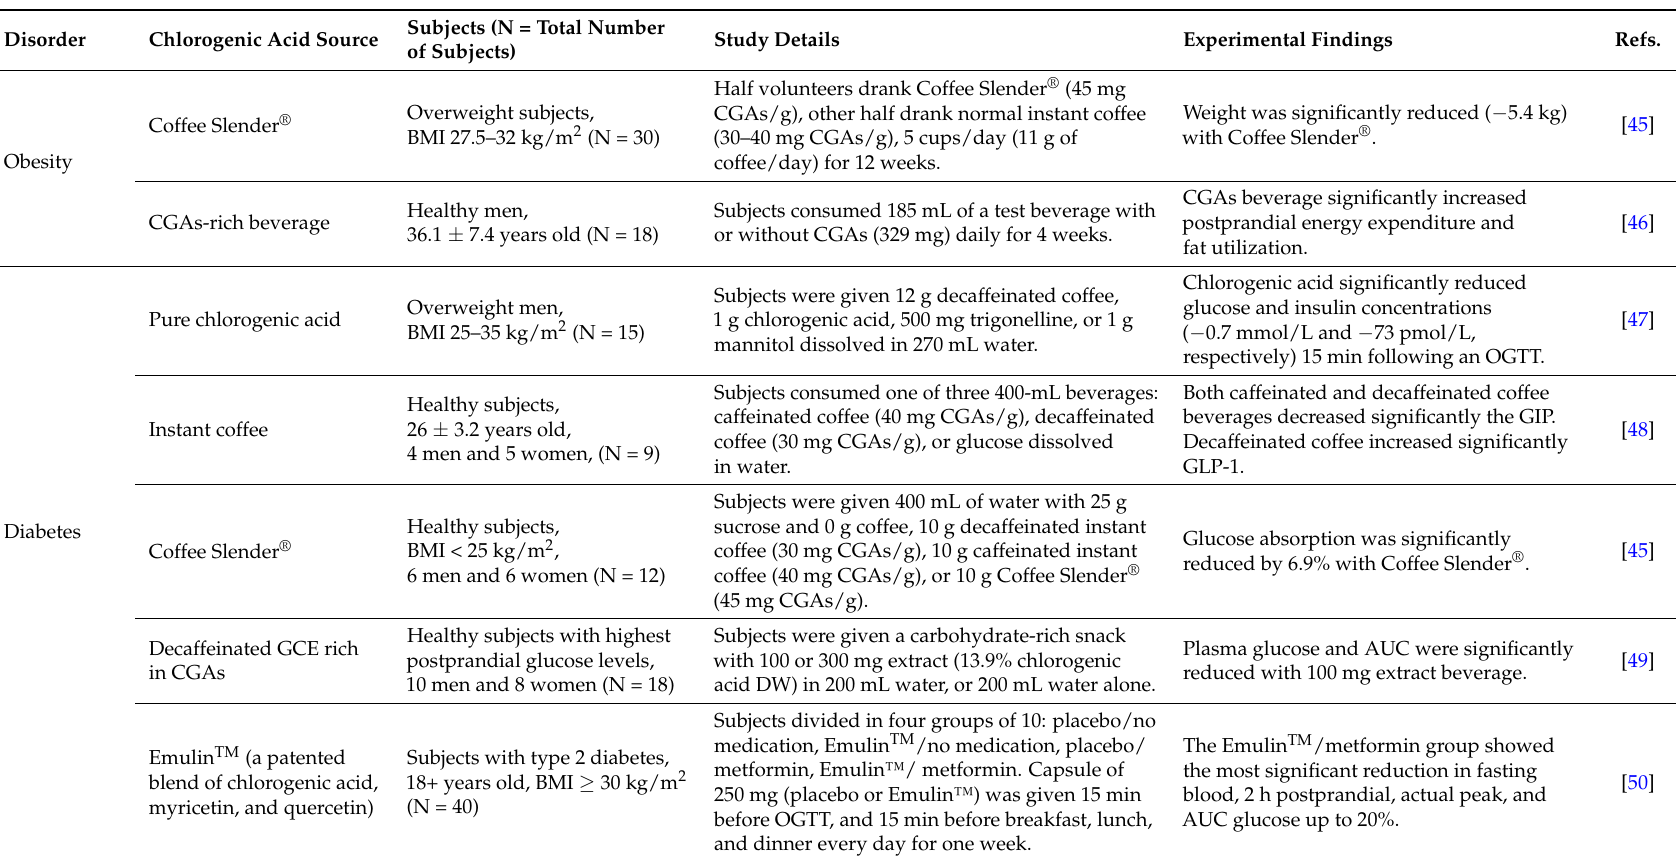
Table 2. Clinical trials evaluating the effect of chlorogenic acid or chlorogenic acid-rich foods and supplements on the prevention and treatment of metabolic syndrome and associated